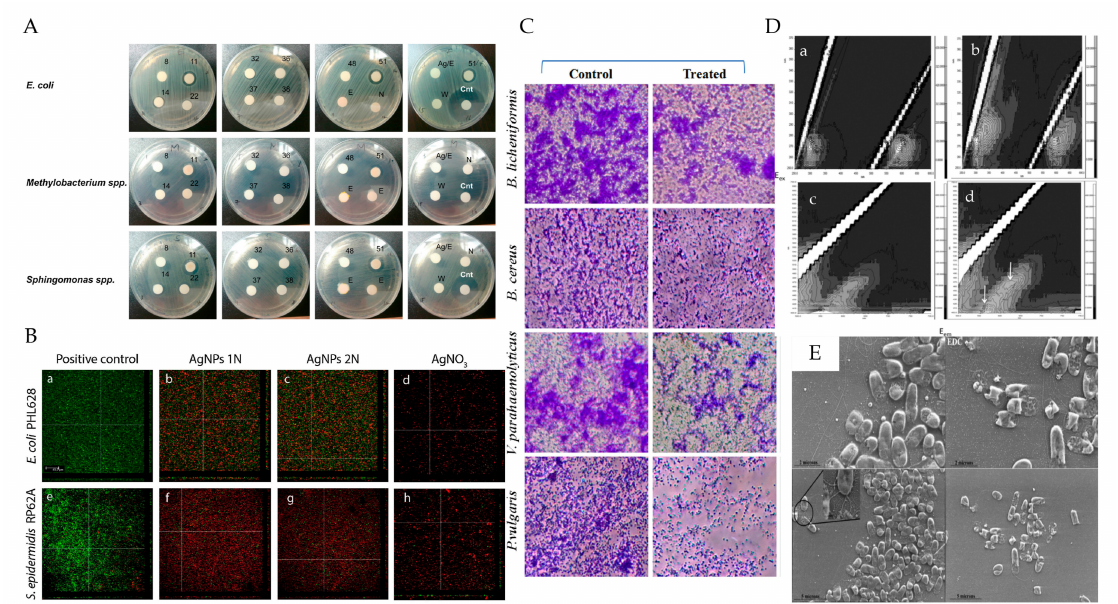
Figure 4. Overall scheme for the illustration of different methods to evaluate the antimicrobial activity of PMNPs: ( A ) antimicrobial tests on agar plate; ( B ) CLSM images of bacterial treated with p-AgNPs; ( C ) light microscopy images of bacterial treated with CS/Ag/ZnO nanocomposite; ( D ) fluorescent fingerprints of DNA of E. coli in the presence of exopolysaccharides based AgNP S ; and ( E ) SEM images of bacterial treated with S-Chi@Au. Reproduced with permission